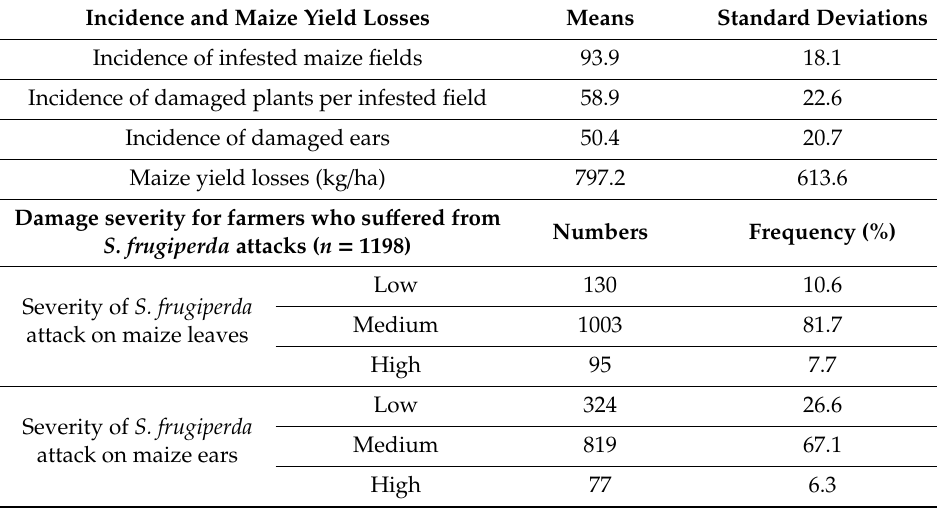
Table 6. Indicators of damage caused by S. frugiperda according to farmers.